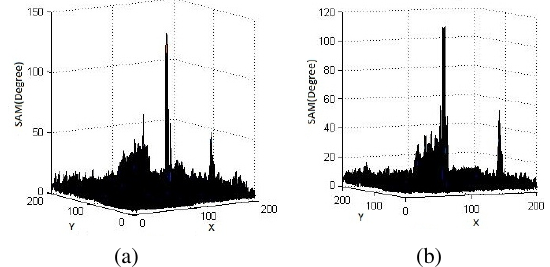
Figure 6: Surface plots showing detailed performance of SAM for q = 2 on AVIRIS data: (a) Bicubic interpolation, and (b) Proposed approach.